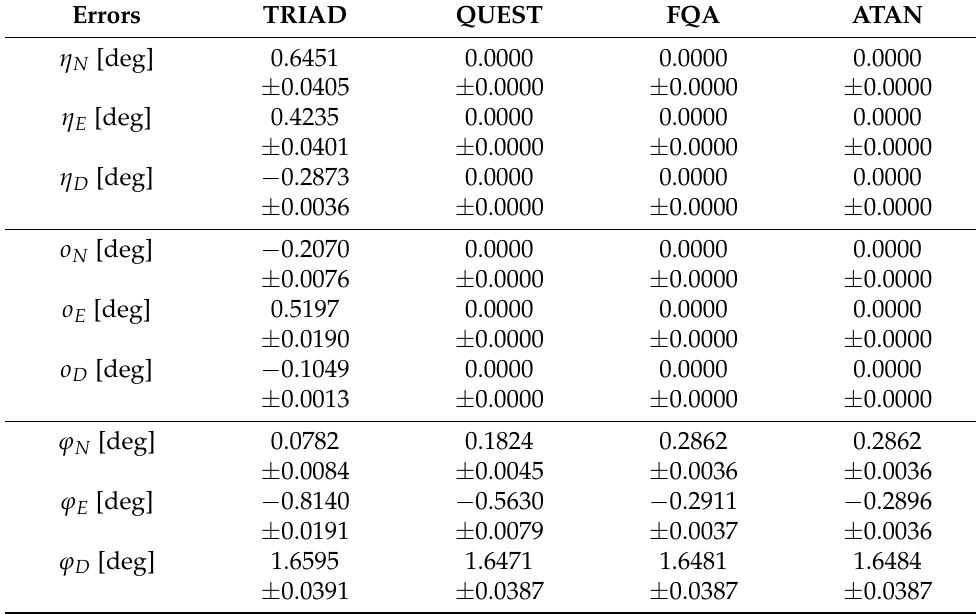
Table 2. Estimated DCM normality, orthogonality, and alignment errors at the completion of the simulated test and associated standard uncertainties.